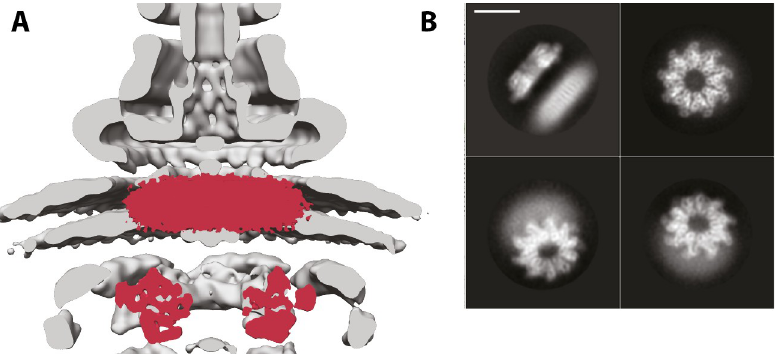
Fig 4. Position of the membrane domain of FlhA in the T3SS nanomachine. a. The volume of Vp -FlhA is shown in red overlaid onto the tomographic reconstruction of the injectisome (EMD-8544). b. Selected 2D class averages of Vp - FlhA show the high level of detail in the cytoplasmic domain and the lower information content in the presumed transmembrane, micelle-embedded, portion. Scale bar is 100A.